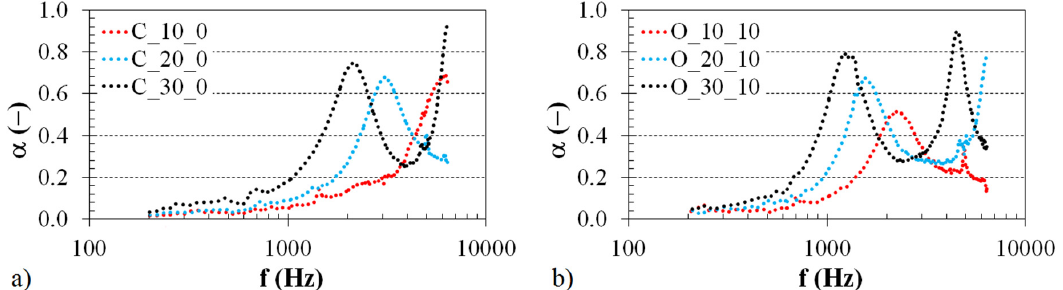
Figure 5. Effect of the sample thickness on the frequency dependencies of the sound absorption coefficient for the investigated ABS samples with a ( a ) Cartesian and ( b ) Octagonal structures.